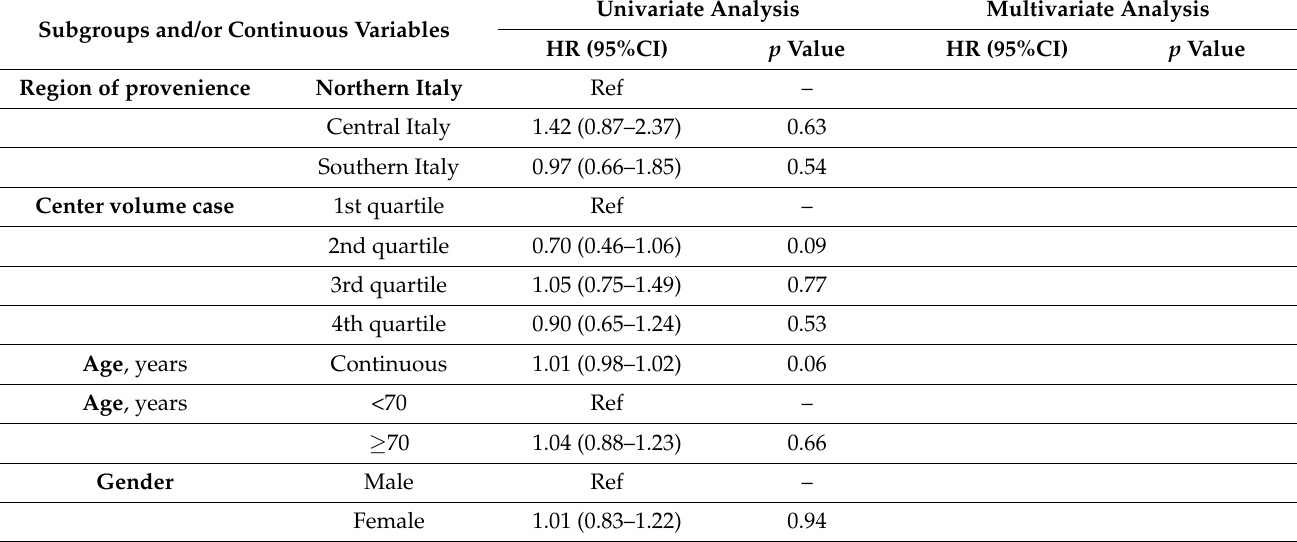
Table 4. Univariable and multivariable logistic regression analysis for delayed time to secondary resection. In bold, value < 0.05. Subgroups and/or Continuous